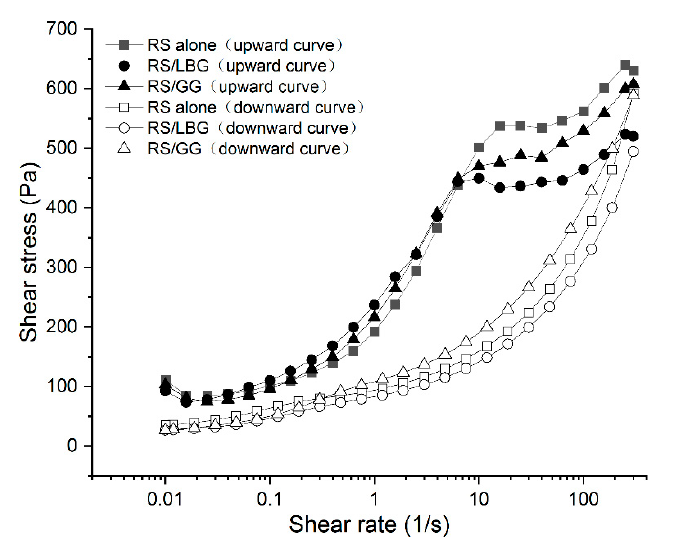
Figure 3. Steady flow curves of RS alone, RS containing locust bean gum (RS/LBG), and RS containing guar gum (RS/GG) .